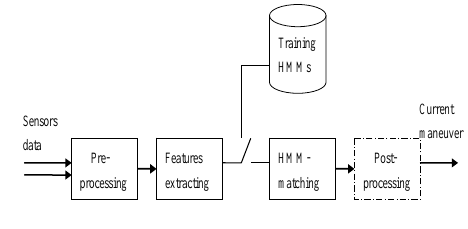
Fig. 4. CHMM training and evaluating